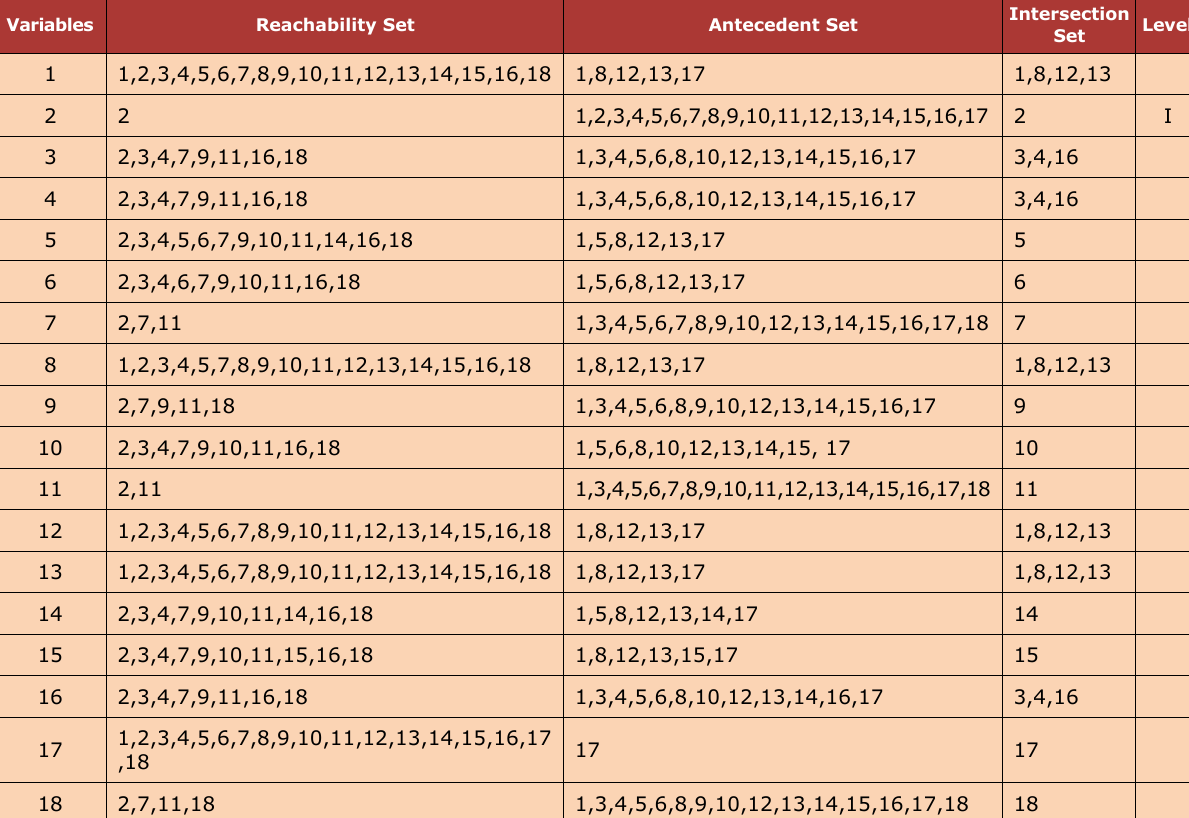
Table 7. Partitioning of Variables-Iteration